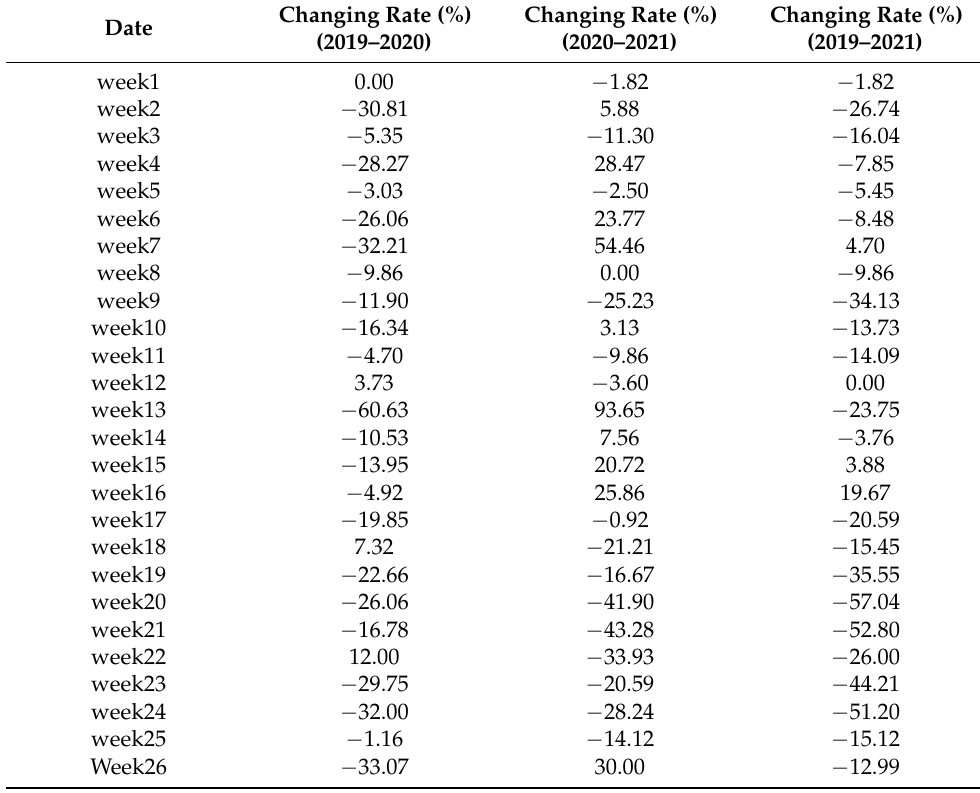
Table 2. Weekly PM2.5 changing rate in Wuhan.